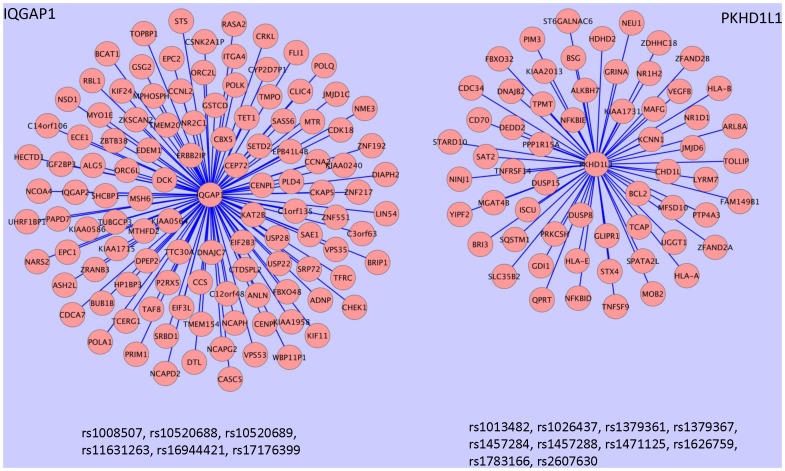
Case studies of polymorphism-induced gene regulation network and the biological implications.The sub-network (cisSplicing_transExpression paradigm) on the left shows that IQGAP1 gene, whose alternative splicing is associated with the genotypes of six SNPs, is a potential regulator of 115 trans- gene RefSeq genes at 113 loci, each of which has the expression level statistically affected by at least one SNP of the same set. These target genes are widely involved in cell cycle (see the left section of
Table 6
). The sub-network (cisExpression_transExpression paradigm) on the right shows that PKHD1L1 gene, whose expression level is associated with the genotypes of ten SNPs, is a potential regulator of 61 trans RefSeq genes at 60 loci, each of which has the expression level statistically affected by at least one SNP of the same set. A few immunity related GO terms are over-represented by these target genes as summerized in the right section of